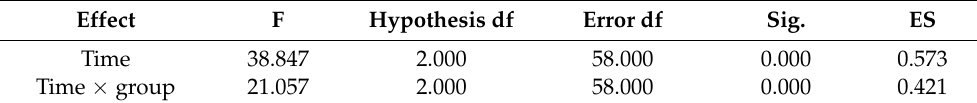
Table 3. Multivariate